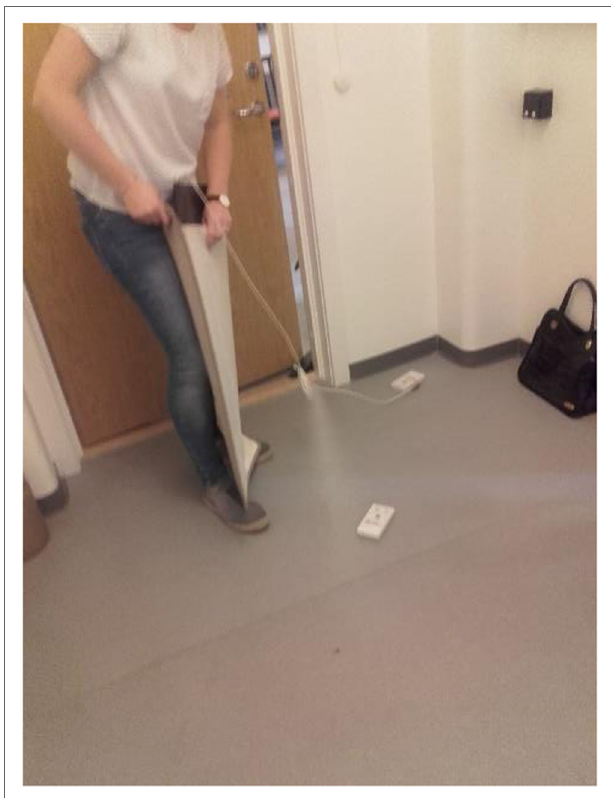
FigUre 4 | Doormat with removable pressure sensitive sensor.